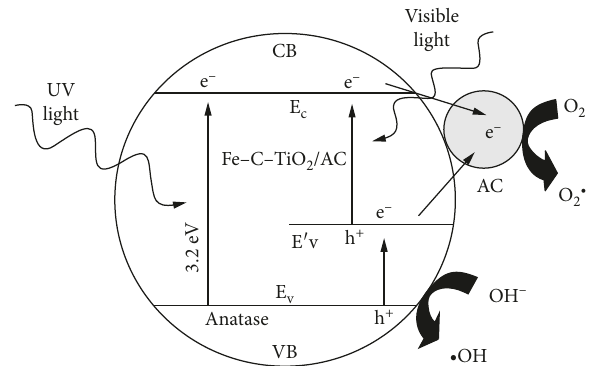
Figure 10: Schematic mechanism of photocatalytic degradation of RhB by Fe-C-TiO 2 /AC (adopted from [12]).